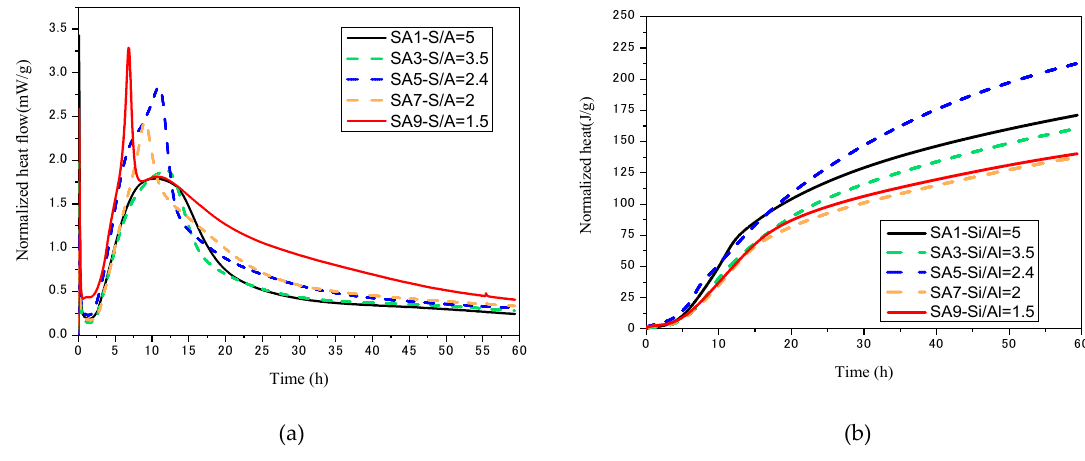
Figure 6. The heat release of slag-cement paste changes with age: ( a ) normalized heat flow; ( b )